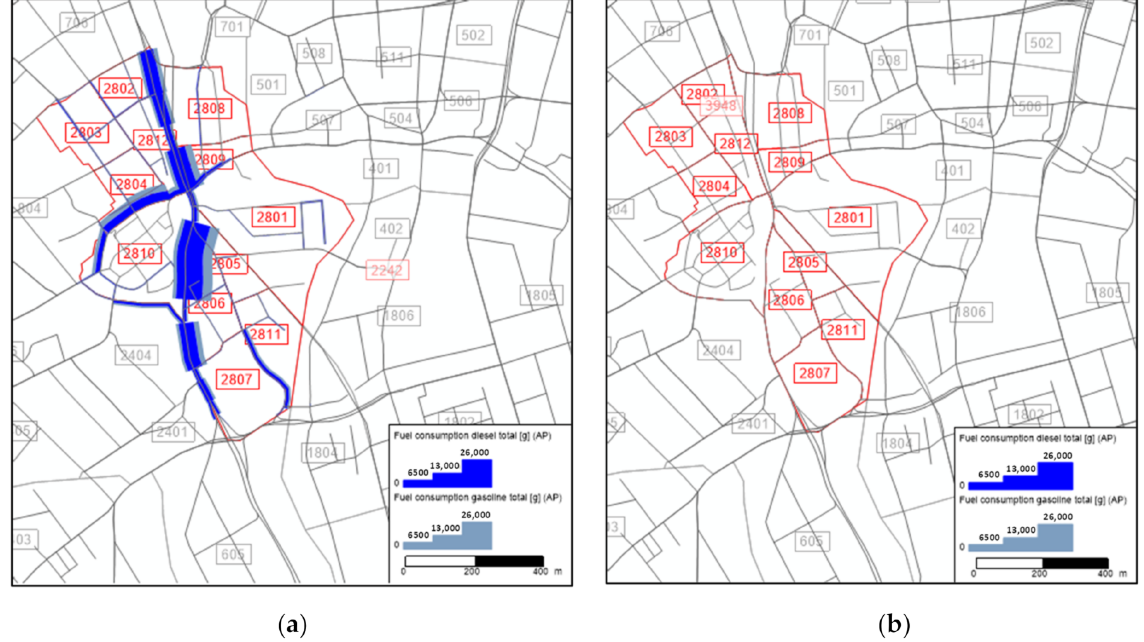
Figure 19. The assessment of fuel consumption diesel total [g] and fuel consumption gasoline total [g] (measures from Group 2) for scenario W0 and optimal scenario (W3)—analysis for the central areas of the city: ( a ) measures for scenario W0; ( b ) measures for scenario